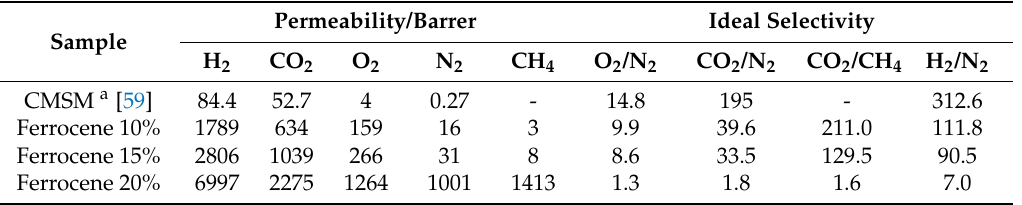
Table 2. Gas permeability and selectivity for ferrocene/PAA-based Fe/C hybrid membranes [63] (Testing condition: 0.05 MPa, 25 ◦ C, the same